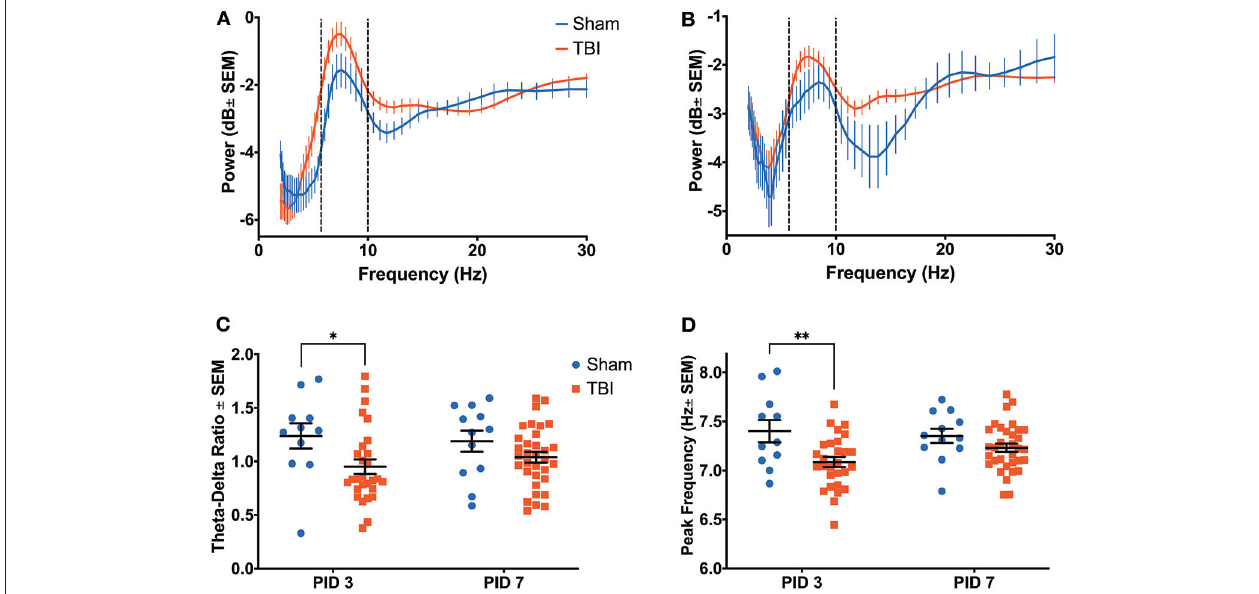
FIGURE 5 | Anterior Cingulate Recovery Following Injury. A significant effect of power ( p < 0.001), time ( p < 0.001) and group ( p < 0.001) on theta oscillatory power was detected by a three-way ANOVA. Dashed lines highlight the theta range (6–10Hz). (A) A power spectral density from the ACC on PID3 reveals significantly higher theta power in injured animals than shams. (B) This difference persisted on PID7. (C) There was a main effect of group on TDR ( p < 0.05), which was due to a significantly lower ratio in injured animals than sham animals on PID3. (D) There was a main effect of group on the theta frequency with peak power ( p < 0.01), which was due to a significantly lower peak frequency in injured animals than shams on PID3. All data are presented as mean ± SEM, * p < 0.05, ** p < 0.01. Adapted from Paxinos et al. ( 51).